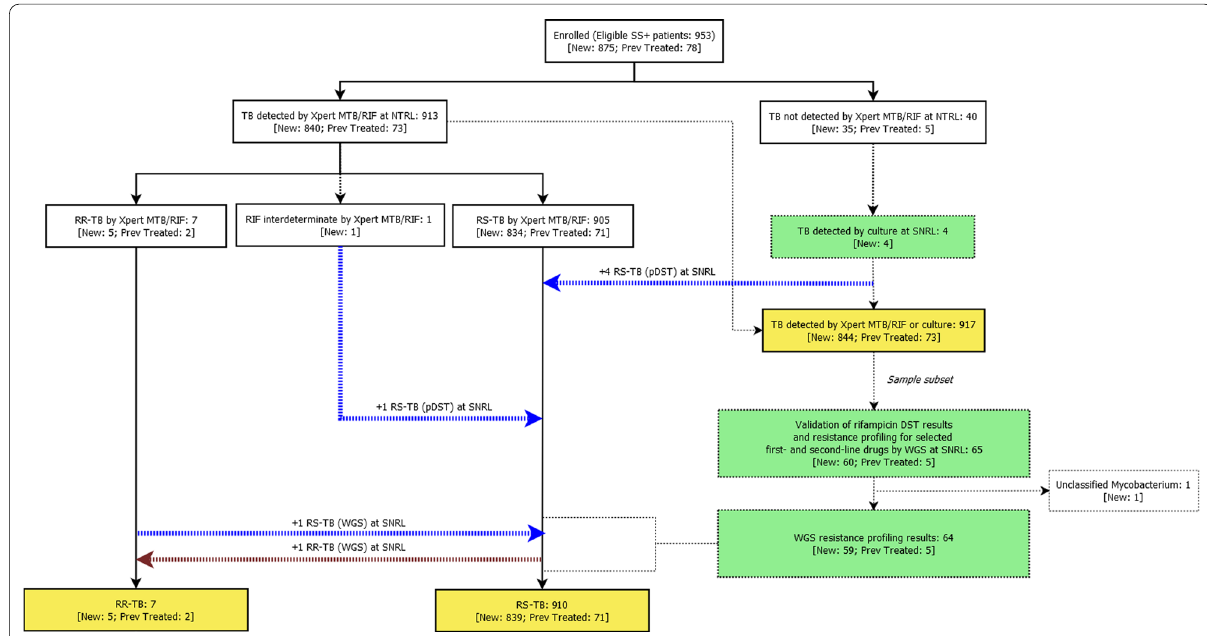
Fig. 1 Timor-Leste’s anti-TB drug resistance survey sample processing workflow. SS Treated previously treated; RIF = pDST phenotypic DST; WGS =